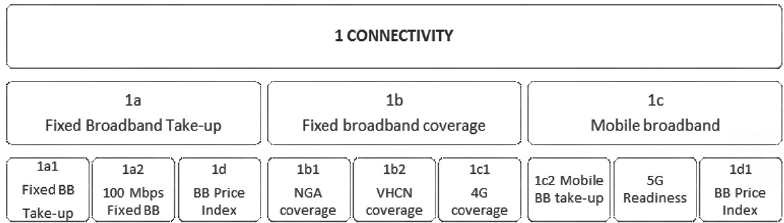
Figure 2. Connectivity indicators in DESI